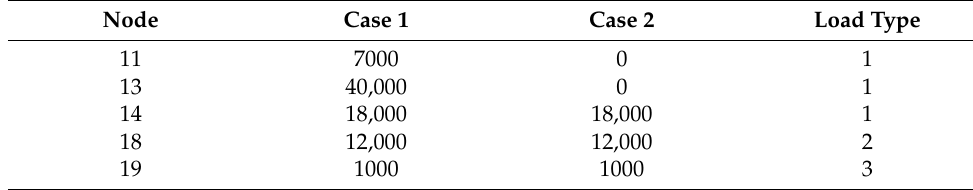
Table 4. Apparent power in VA for each